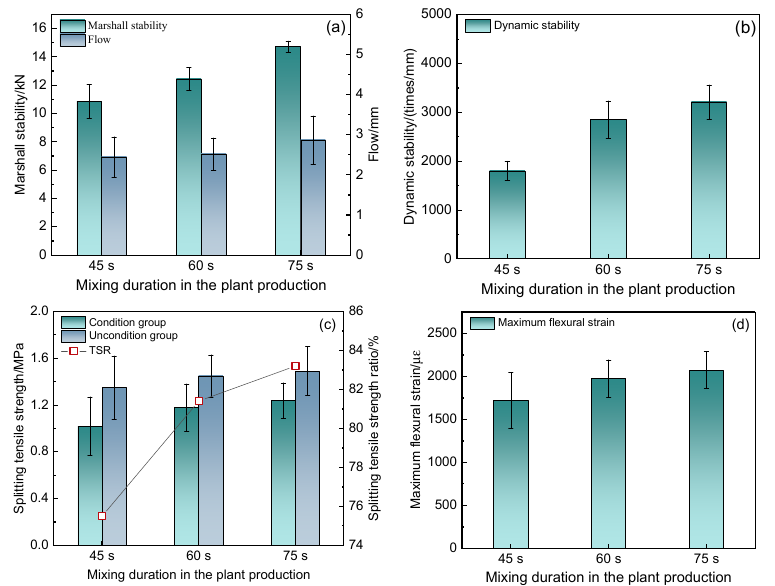
Figure 19. Performance test results for RHMA: ( a ) Marshall stability and flow test; ( b ) rutting test; ( c ) freeze–thaw splitting test; ( d ) low-temperature cracking test.